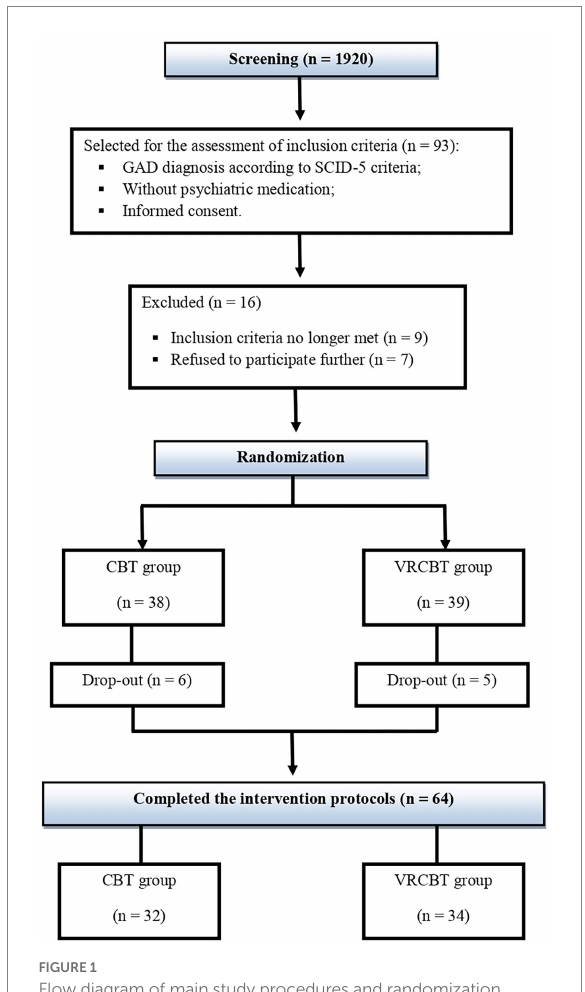
FIGURE 1 Flow diagram of main study procedures and randomization